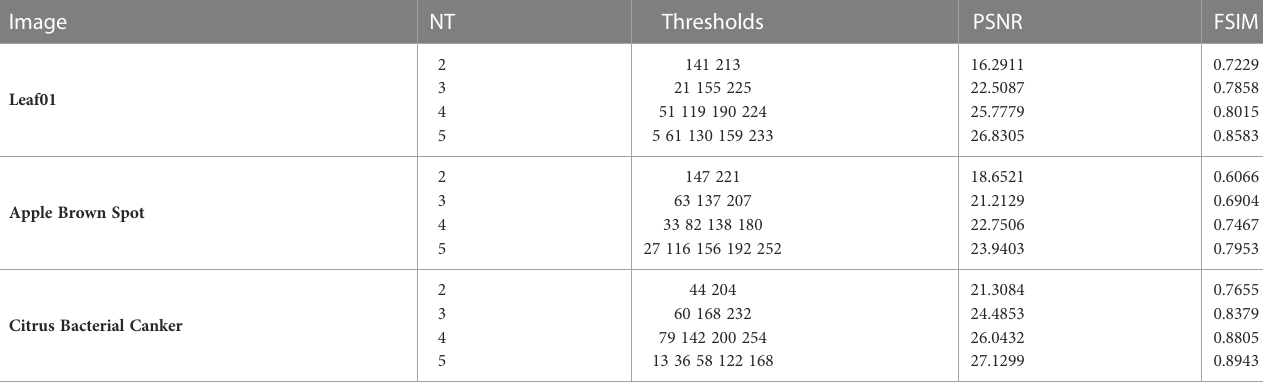
TABLE 4 Experimental results of ICAPSA with different threshold